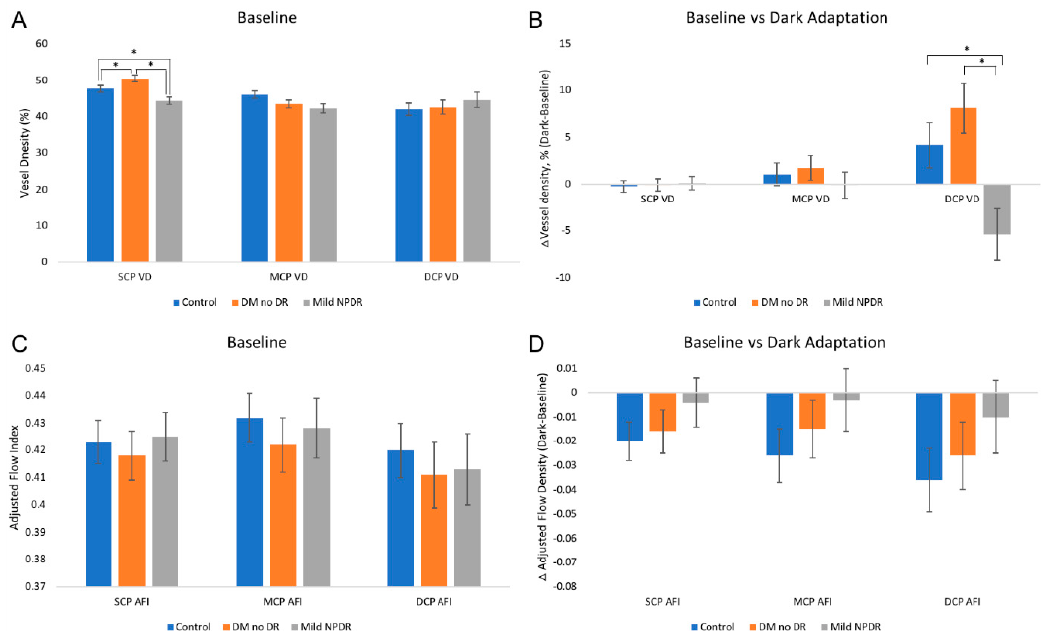
Figure 4. Parafoveal vessel density and adjusted flow index on OCTA at baseline and after dark adaptation. ( A ) Absolute vessel density (VD) and ( C ) adjusted flow index (AFI) at baseline in ambient light before any adaptation. At baseline, the mild NPDR group had significantly decreased superficial capillary plexus (SCP) VD compared to the control and DM no DR groups. The DM no DR group also had significantly higher VD than controls. VD and AFI after dark adaptation in ( B , D ) respectively are shown as values relative to baseline, which was set to zero. ( B ) shows significantly lower change in deep vascular plexus (DCP) VD in the mild NPDR group compared to the control and DM no DR groups who had increased DCP VD during dark adaptation. All timepoints with statistically significant differences ( p < 0.05) between groups are marked with an asterisk (*). Error bars represent standard errors. Abbreviations: VD—vessel density, AFI—adjusted flow index